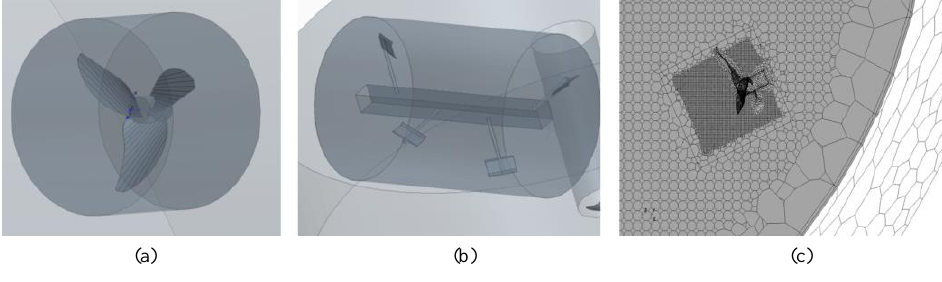
Fig. 3. Geometry imported in the CFD model for: (a) propeller RB with rounded blades; (b) paddle system RP with rectangular plates; (c) propeller PB with pointed blades. In (c) the meshes of the regions and sub-regions inside the cylindrical volume of the laboratory digester are shown.